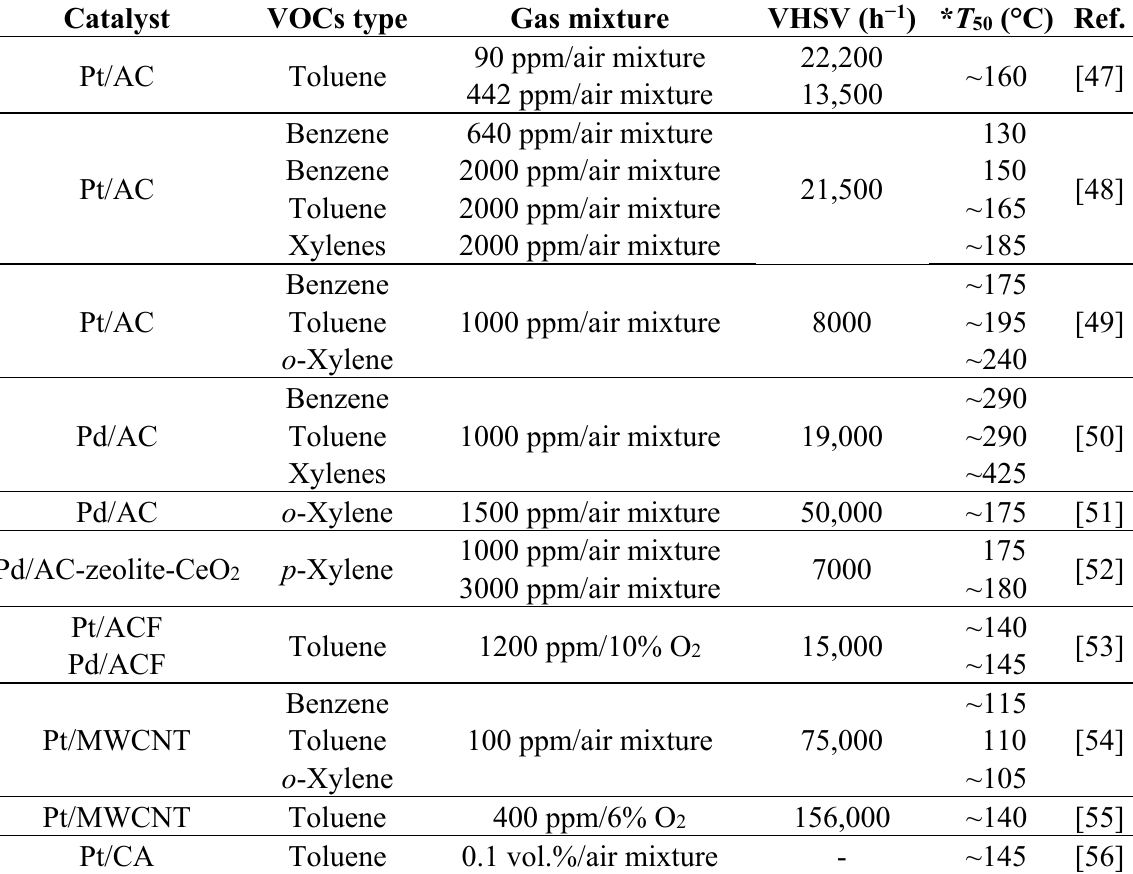
Table 1. Catalytic oxidation of benzene, toluene and xylenes (BTX) over noble metal catalysts supported on carbon